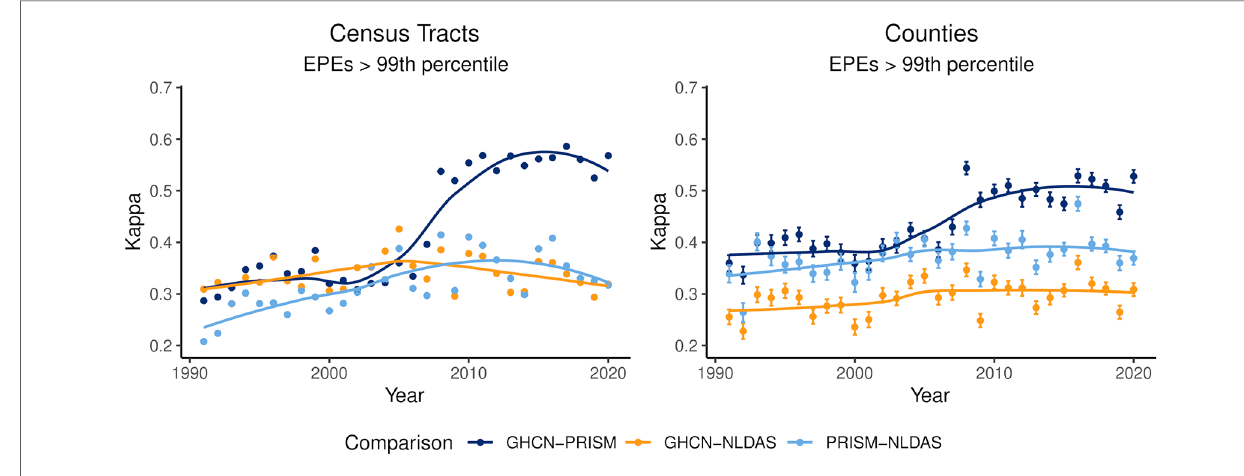
FIGURE 2 Annual trends in EPE identi fi cation agreement according to data source and exposure assessment geography. Point estimates and their 95% con fi dence intervals for annual Cohen ’ s kappa statistic for comparisons of daily EPE identi fi cation for each 2-way comparison between data sources — GHCN vs. PRISM, GHCN vs. NLDAS, and PRISM vs. NLDAS — are presented. A LOESS-smoothed trendline is included to aid in visually identifying temporal trends in agreement. Comparisons among data sources at census tracts appear on the left and comparisons among counties appear on the right.